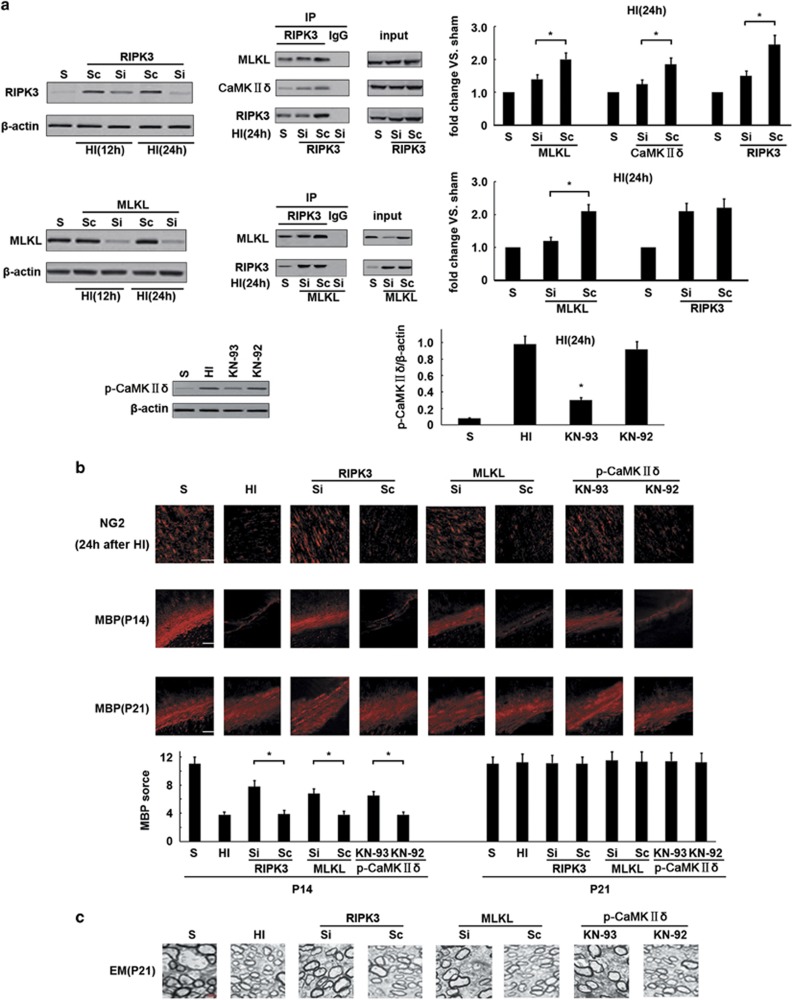
Inhibition of the RIPK3-MLKL interaction or the RIPK3-CaMKIIδ interaction attenuates the disruption of myelin development in neonatal rats subjected to HI insult. (a) Western blotting and immunoprecipitation assays on the ipsilateral brain tissue indicate that RIPK3 siRNA significantly reduces RIPK3 expression 12 and 24 h after HI, and that the interactions of RIPK3 with MLKL and CaMKIIδ are decreased 24 h after HI. MLKL siRNA significantly reduced MLKL expression 12 and 24 h after HI and the RIPK3-MLKL interaction 24 h after HI. KN-93 significantly inhibited CaMKIIδ phosphorylation 24 h after HI. Data are presented as means ±S.E.M. from three independent experiments. N=6 for each group in each experiment (P<0.05, comparing the Si group with the Sc group; or comparing the KN-93 group with the negative control KN-92 group). (b) Representative images of immunostaining for NG2 and MBP in the corpus callosum of the ipsilateral hemisphere and quantification of the MBP score. The MBP score was assessed in three regions (medial, middle, and lateral) along the corpus callosum in each section. Four sections per brain were analyzed. Data are presented as means±S.E.M. from three independent experiments. N=6 for each group in each experiment. The number of OPCs (NG2-positive cells) was significantly decreased in the ipsilateral hemisphere 24 h after HI. There was also a marked decrease in MBP expression at P14. However, at P21, MBP levels were not significantly different between HI and sham rats. Inhibition of RIPK3 and MLKL via siRNA, or inactivation of CaMKII with KN-93, attenuated OPCs depletion 24 h after HI and increased MBP levels at P14 (scale bar=40 μm) (P<0.05, comparing the Si group with the Sc group; or comparing the KN-93 group with the KN-92 group). (c) Representative transmission electron microscopy images of the ultra-structure of myelin at P21. Myelin was well-developed with a compact structure in sham rats, whereas in the HI rats, myelin exhibited obvious stratification and fragmentation. Inhibition of RIPK3 and MLKL via siRNA, or inactivation of CaMKII with KN-93, partly attenuated the disruption to myelin development (scale bar=2 μm). S: sham; HI: hypoxia–ischemia; Si: RIPK3 or MLKL siRNA; Sc: RIPK3 or MLKL siRNA scramble; KN-93: CaMKII inhibitor; KN-92: negative control for KN-93